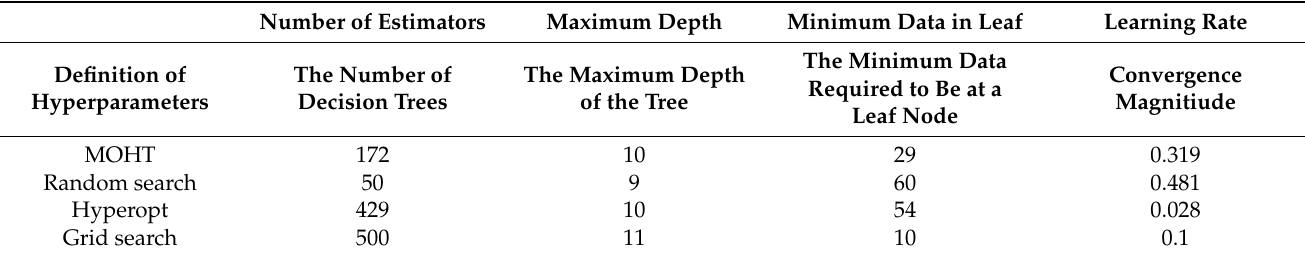
Table 4. The optimal values of hyperparameters.